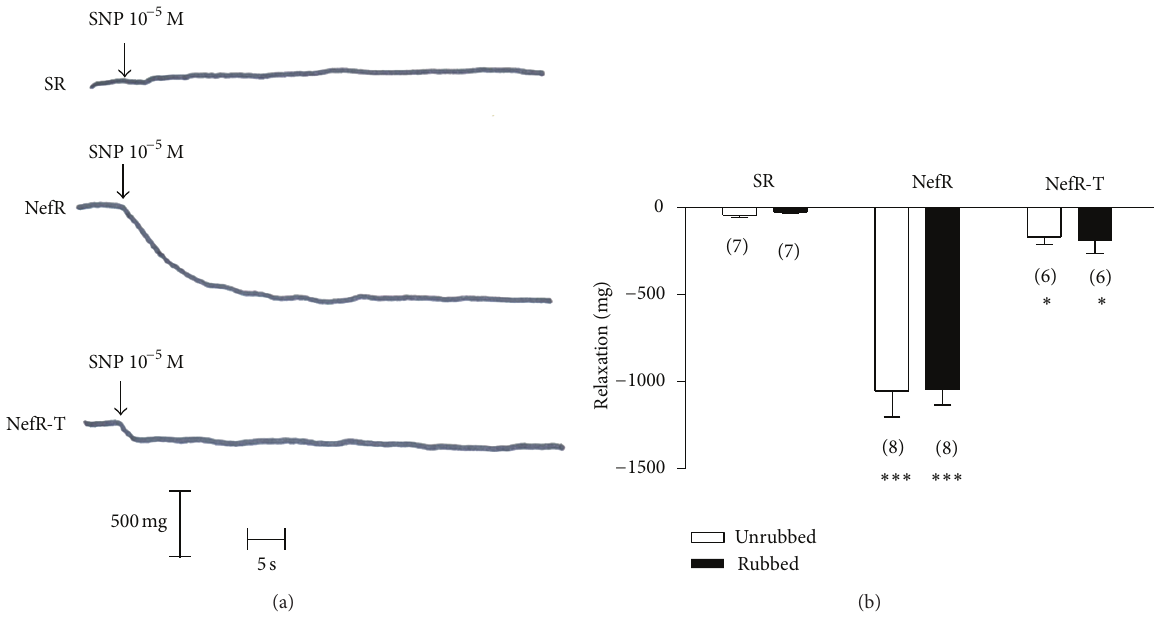
Figure 1: Effect of SNP 10 −5 M on basal tone. (a) Tracing of a typical experiment of administration of SNP (arrows) on basal tone in unrubbed aortic ring from SR (upper), NefR, (middle) and NefR-T (lower). (b) Average of effect of SNP on basal tone in unrubbed (white bars) and rubbed (black bars) aortic rings from SR, NefR, and NefR-T. ∗∗∗ 𝑃 < 0.001 NefR versus SR; ∗ 𝑃 < 0.05 NefR-T versus SR. Two way ANOVA. Data are expressed as mean ± standard error. The number of rings is given in parentheses.